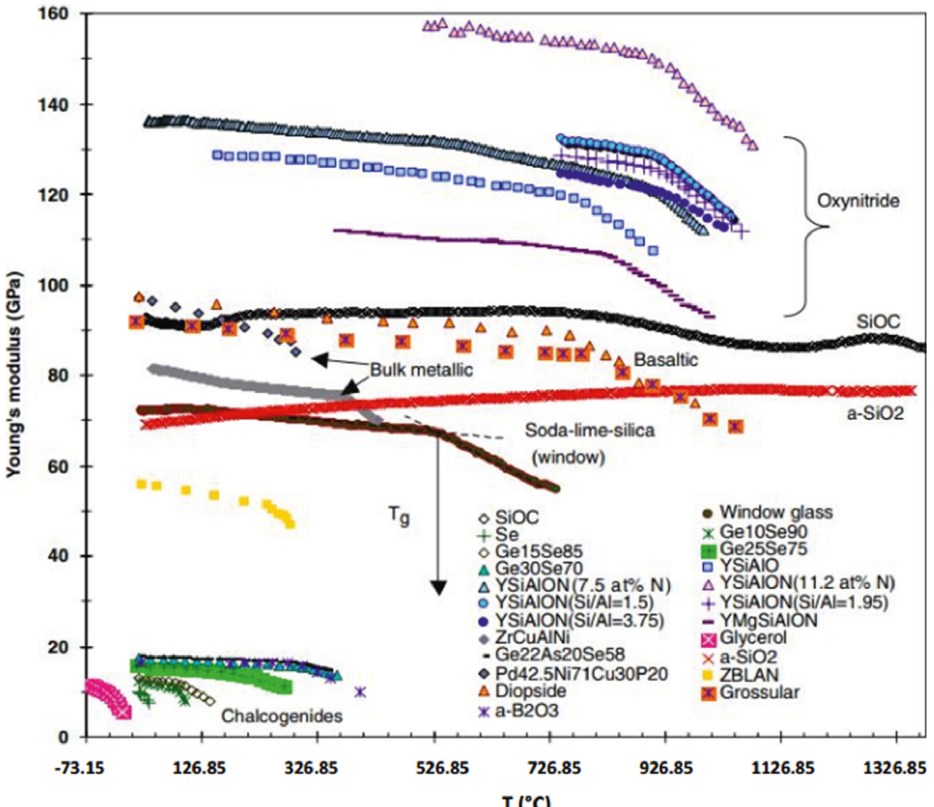
Figure 4: MOE variation in SLS glass and other glass types, as a function of temperature, as reported in